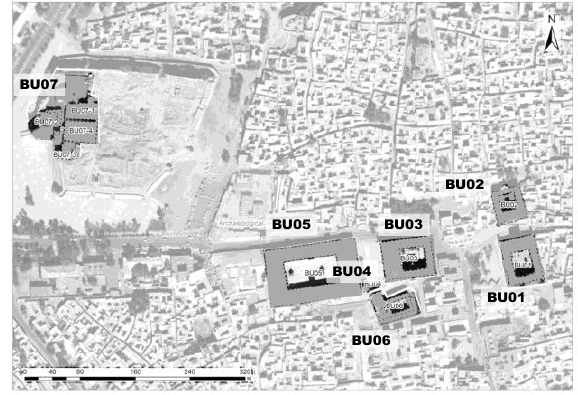
Figure 7. Location of the historic buildings within the historic